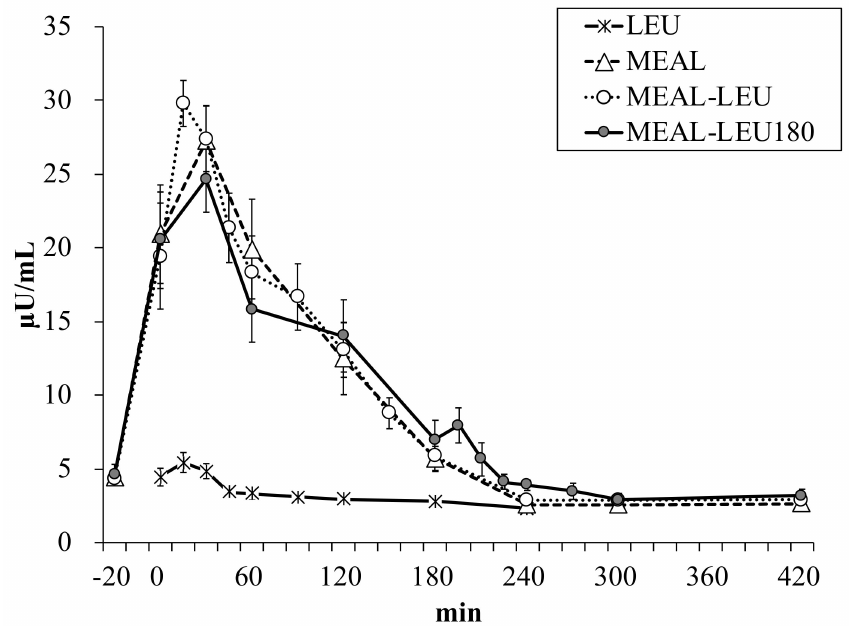
Figure 3. Mean ± SE ( n = 10) plasma insulin concentration changes over time. LEU, intake of leucine only; MEAL, intake of mixed meal only; MEAL-LEU, intake of mixed meal with leucine intake immediately afterwards; MEAL-LEU180, intake test mixed meal followed by leucine intake after 180 min. Table 2. Plasma insulin concentration of the pharmacokinetics parameters. LEU